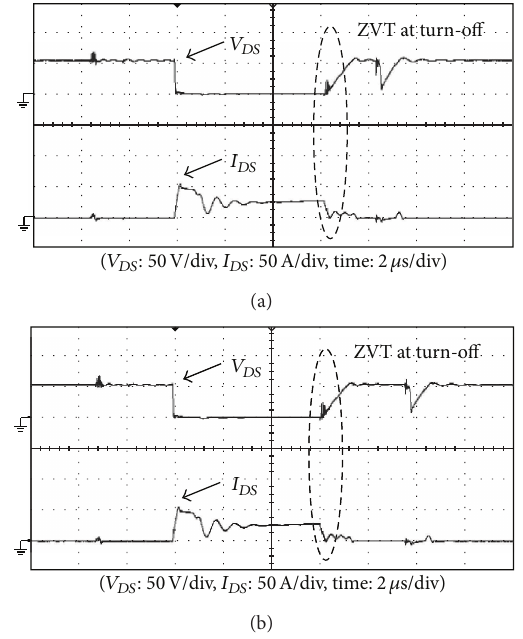
Figure 8: Measured voltage 𝑉 𝐷𝑆 and current 𝐼 𝐷𝑆 waveforms of (a) switch 𝑀 1𝐵 and (b) switch 𝑀 2𝐵 under 50% of full load when the proposed PV power conversion system with the single-capacitor snubber.